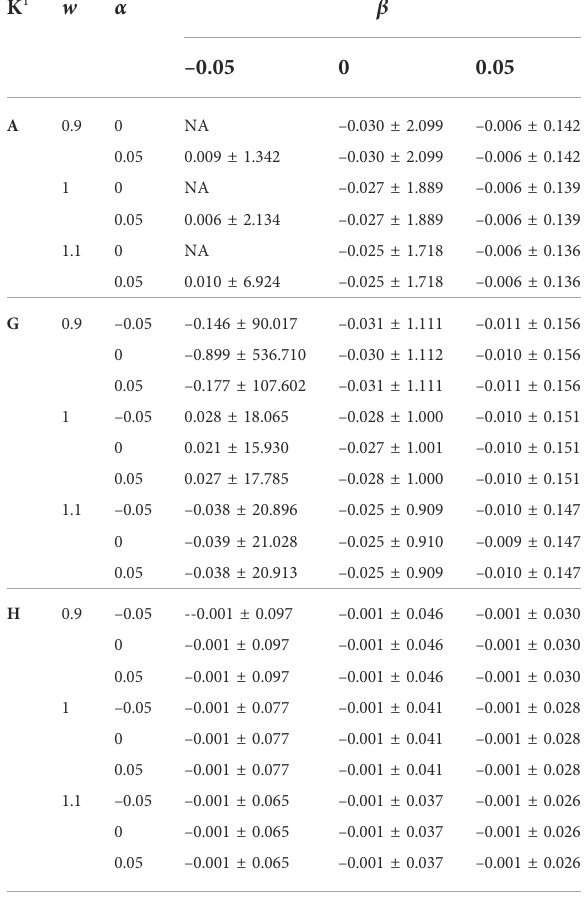
TABLE 2 The effect of w , α , and β ( w K + α 11 ′ + β I) on the distribution of offdiag(K − 1 ). K 1